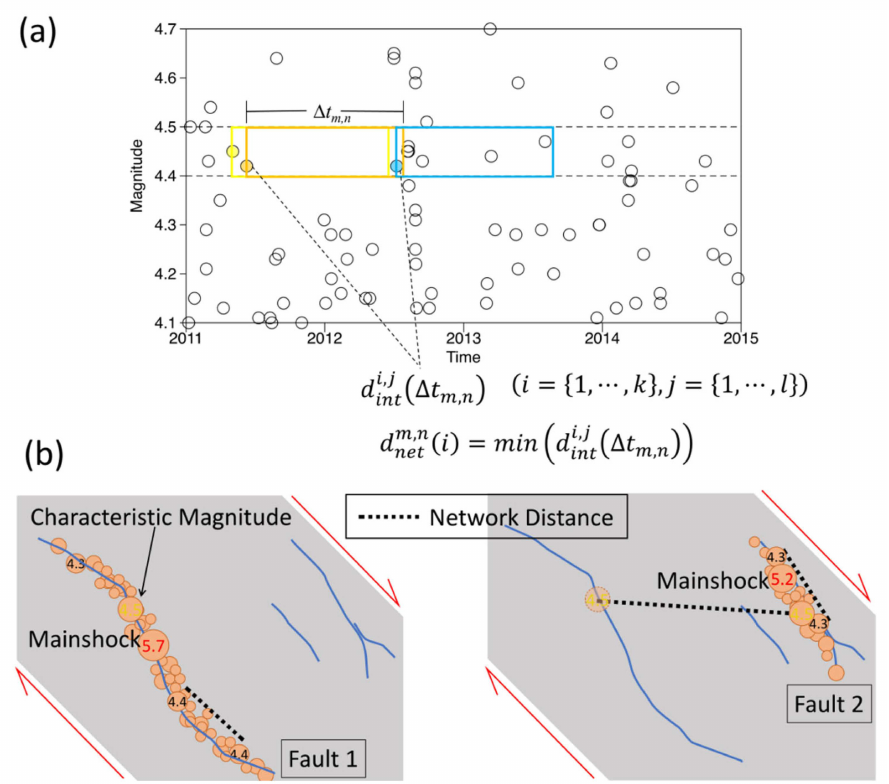
Figure 2. Schematic illustration of the interevent distance and network distance, assuming the characteristic magnitude to be 4.5. ( a ) The distances between the first event (colored circles) and its subsequent events (circles) occurred in the time window ∆ t m , n (colored boxes), which are defined as interevent distances, and the shortest interevent distance for the i th event with specified magnitude ( i ) . ( b ) The faults (blue lines) m and the time window ∆ t m , n is defined as network distance d m , n net comprise a local network of earthquakes. The dynamic stress from the M5.7 event may trigger an M5.2 event on an adjacent fault in the network. Therefore, the two earthquake sequences could occur within the interevent time of the M5.7 earthquake. The network distances of smaller aftershocks following the M5.7 and M5.2 events would mostly take place on a single fault (fault 1 or fault 2); contrarily, the aftershocks with magnitudes equal or larger than the characteristic magnitude are less likely to happen on the same fault because of insufficient stress. Since the events with magnitudes equal or larger than the characteristic magnitude are more likely to occur on the adjacent faults in a fault network, the dimension of the fault network can be reasonably explained by the maximum network